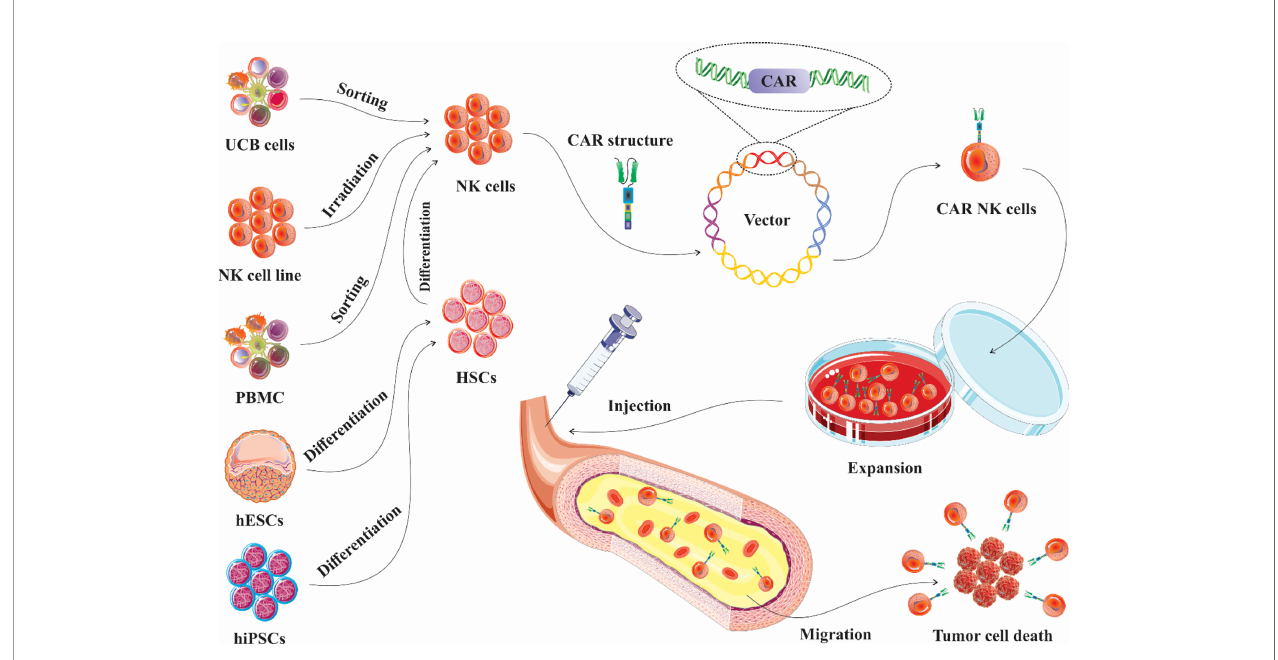
FIGURE 2 | Sources and generation procedure of CAR-NK cells. Isolated or established NK cells from various sources (e.g., PB, UCB, HSCs, hESCs, and hiPSCs) can be activated and genetically modi fi ed with CAR-expressing vectors (e.g., lentivirus or retrovirus) and then cultivated in NK cell-speci fi c expansion media with cytokines for GMP-grade clinical use. UCB, Umbilical cord blood; PB, Peripheral blood; hiPSCs, Human induced pluripotent stem cell; hESC, Human embryonic stem cell; HSC, Hematopoietic stem cell; CAR-NK, Chimeric antigen receptor-natural killer cells; GMP, Good manufacturing